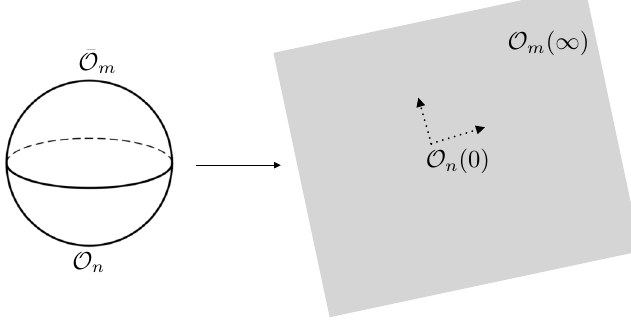
Figure 2 . Coulomb branch operators in flat space get mapped to north ( N ) and south ( S ) pole insertions on S 4